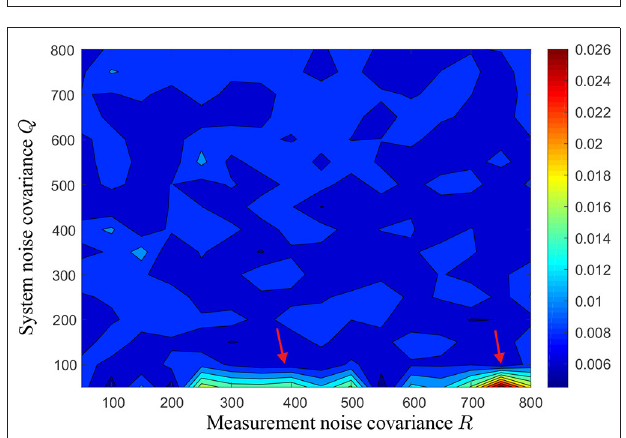
FIGURE 9 | Root mean square error (RMSE) of VSEKF considering variation of system and measurement noise